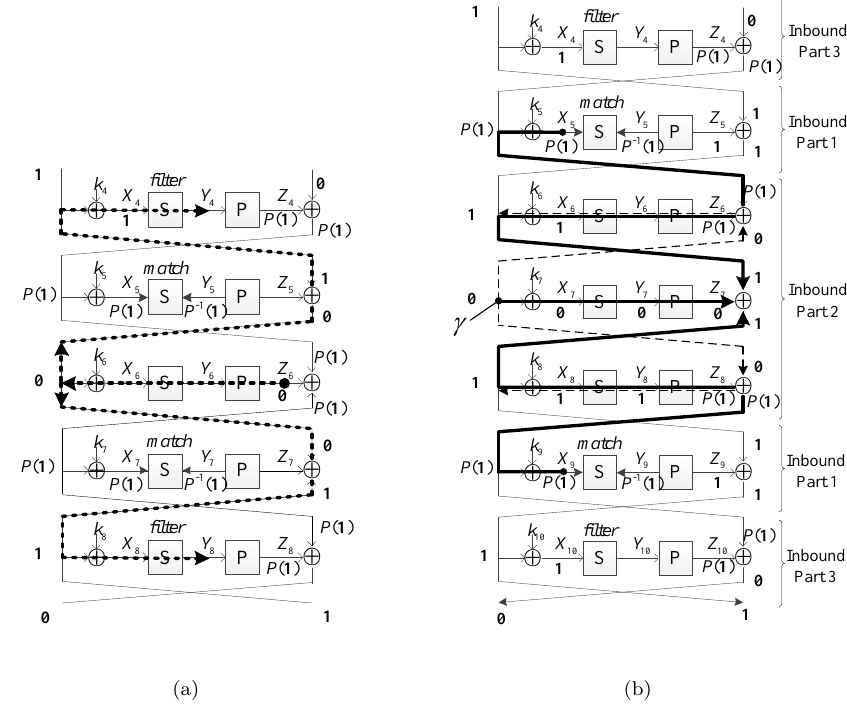
Figure 3: (a) Old 5-Round Inbound Phase, (b) New 7-Round Inbound Phase inbound